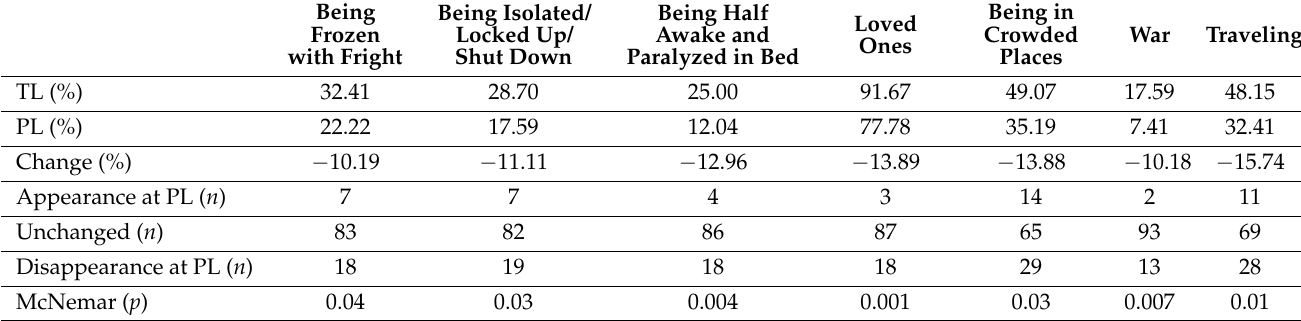
Figure 3. Frequency of dream contents. The bars represent the 10 most frequently reported dream contents during total lockdown (upper box) and post-lockdown (lower box). Table 5. Dream contents exhibiting a significant difference (McNemar test) between total lockdown (TL) and post-lockdown (PL). For each dream content, we provide the following information: percent- age of individuals reporting the specific dream content at TL and PL; TL vs. PL difference (TL–PL); number of participants exhibiting appearance, disappearance or unchanged presence of the specific content at PL; p -value at the McNemar